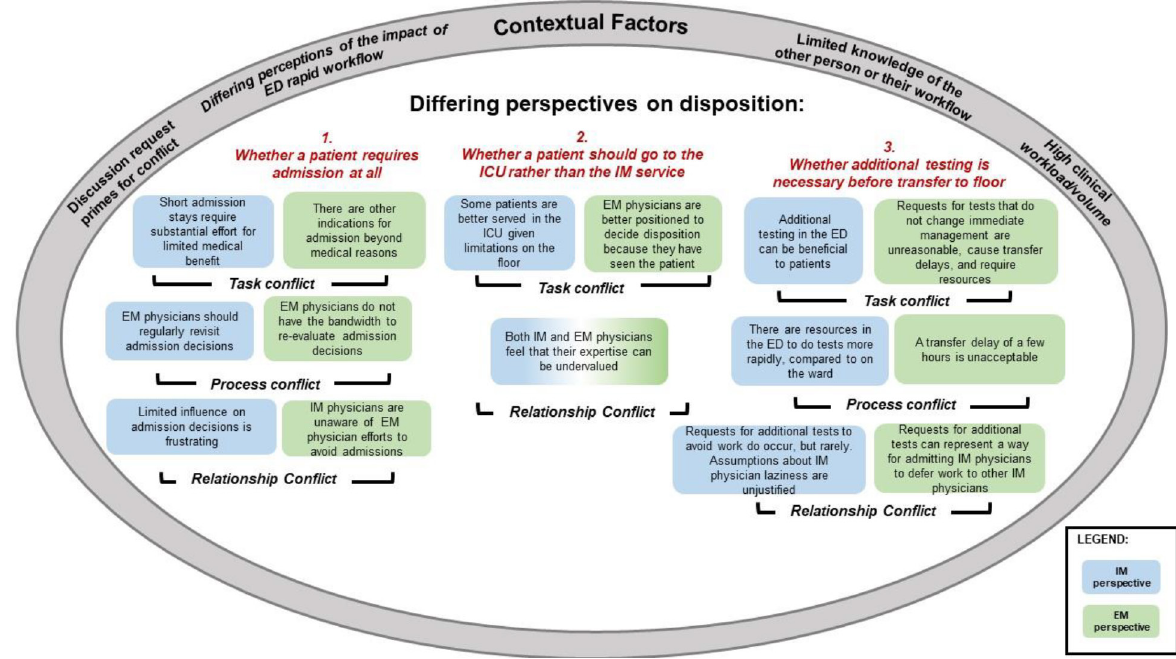
Figure 2. Differences in perspectives regarding disposition decisions result in task, process, relationship conflict between internal medicine physicians and emergency physicians at patient handover. Contextual factors contribute to or exacerbate conflict. ED , emergency department; EM , emergency medicine; ICU , intensive care unit; IM , internal